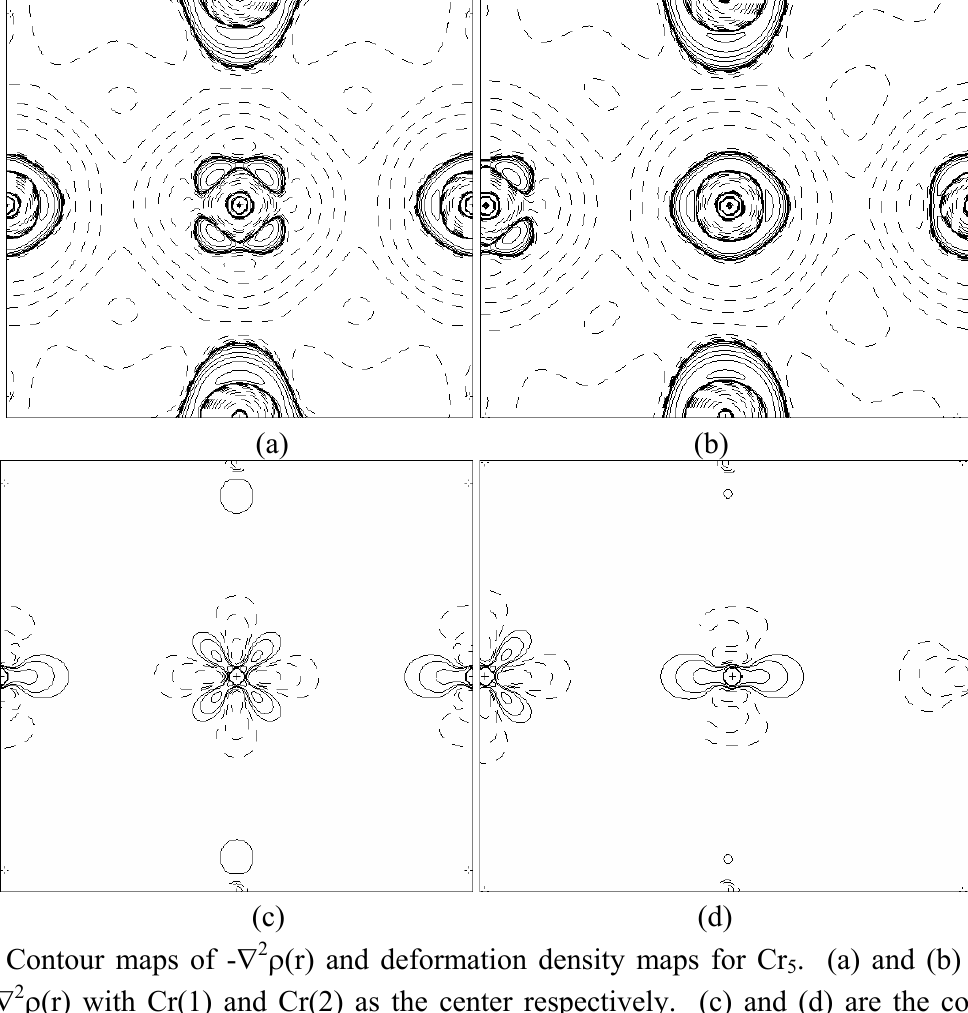
. (a) and (b) are contour 5